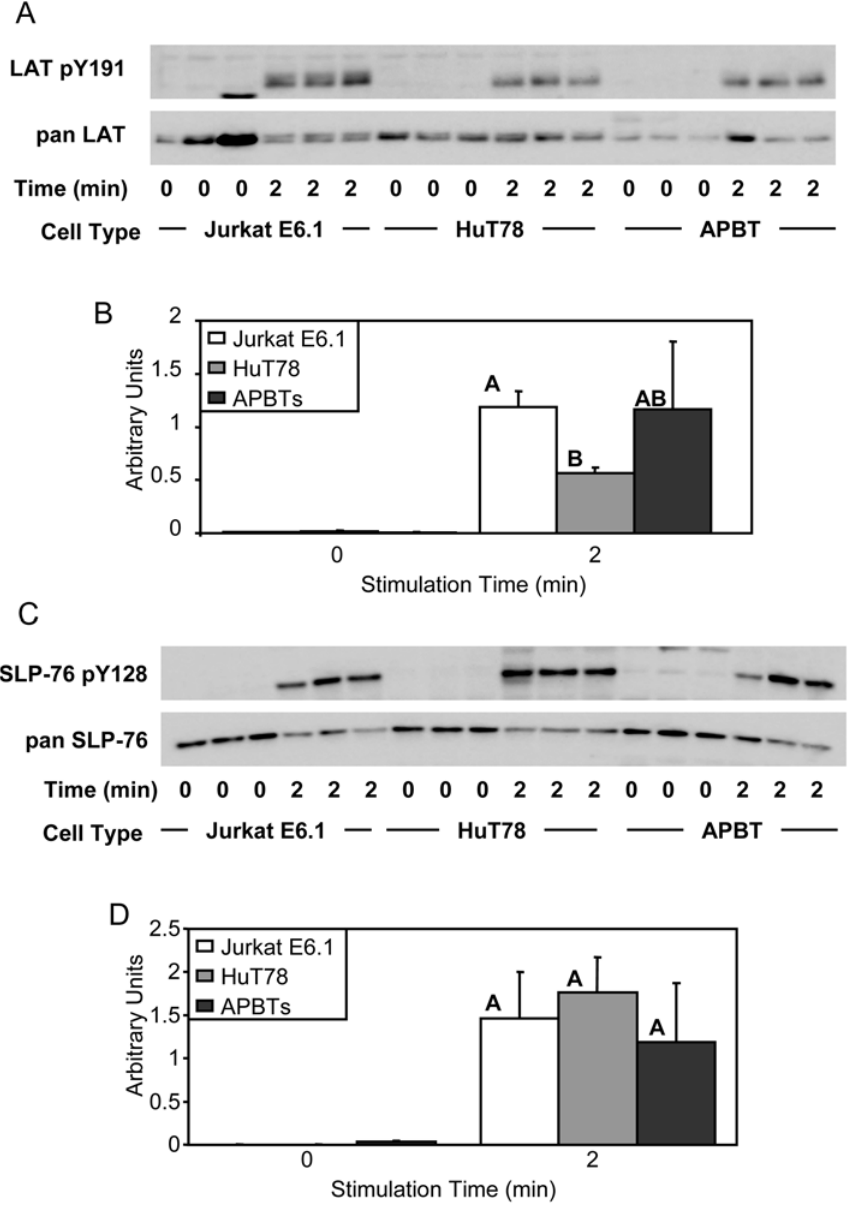
Figure 4. Jurkat E6.1 T cells, HuT78 T cells, and APBTs have similar levels of LAT and SLP-76 phosphorylation. (A) Three samples of Jurkat E6.1 T cells, HuT78 T cells, and APBTs were stimulated and the cellular proteins were separated by SDS-PAGE. The site-specific phosphorylation and expression of LAT was assessed by immunoblotting using LAT pY191 (top) and pan-LAT (bottom) antibodies. (B) The immunoblots were analyzed by densitometry and the ratio of the intensity of the phosphospecific LAT band to the pan-LAT band for each cell line was averaged. Letters represents significant differences of p , 0.01. (C) Three samples of Jurkat E6.1 T cells, HuT78 T cells, and APBTs were stimulated and the cellular proteins were separated by SDS-PAGE. The site-specific phosphorylation and expression of SLP-76 was assessed by immunoblotting using SLP-76 pY128 (top) and pan-SLP-76 (bottom) antibodies. (D) The immunoblots were analyzed by densitometry and the ratio of the intensity of the phosphospecific SLP-76 band to the pan-SLP-76 band for each cell line was averaged. There were no significant differences between cell lines and p . 0.25.